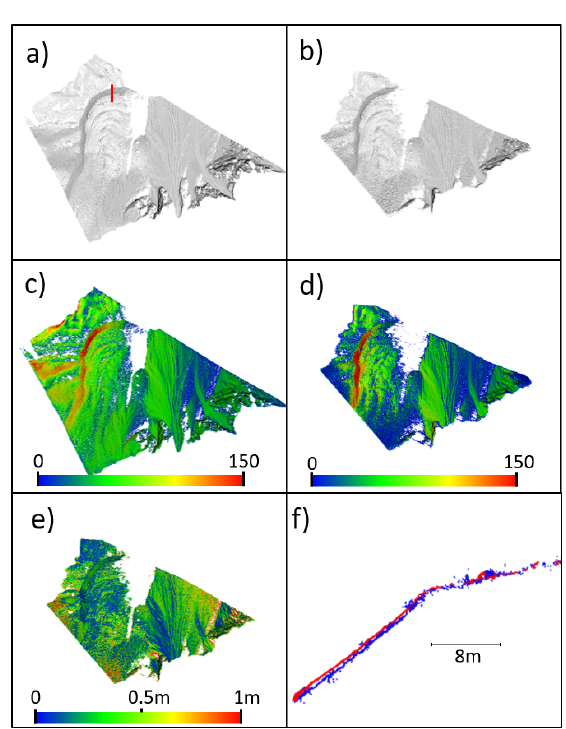
Figure 6. a) : Point clouds comparison: a) point cloud from LiDAR, b) point cloud from stereo images, number of points in a sphere of 50cm for the LiDAR c) and for the stereo images d), e) distance between the two clouds, f) profile extracted from the two clouds (red LiDAR, blue stereo). The position of the profile is represented in red on a).